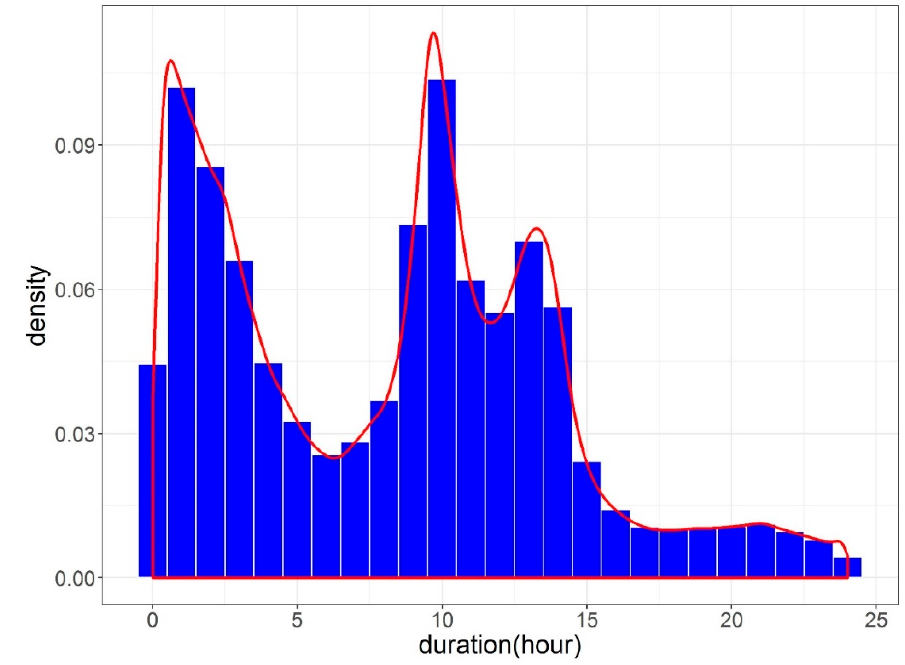
Figure 3. The distribution of staying activity duration (bin width = 1).